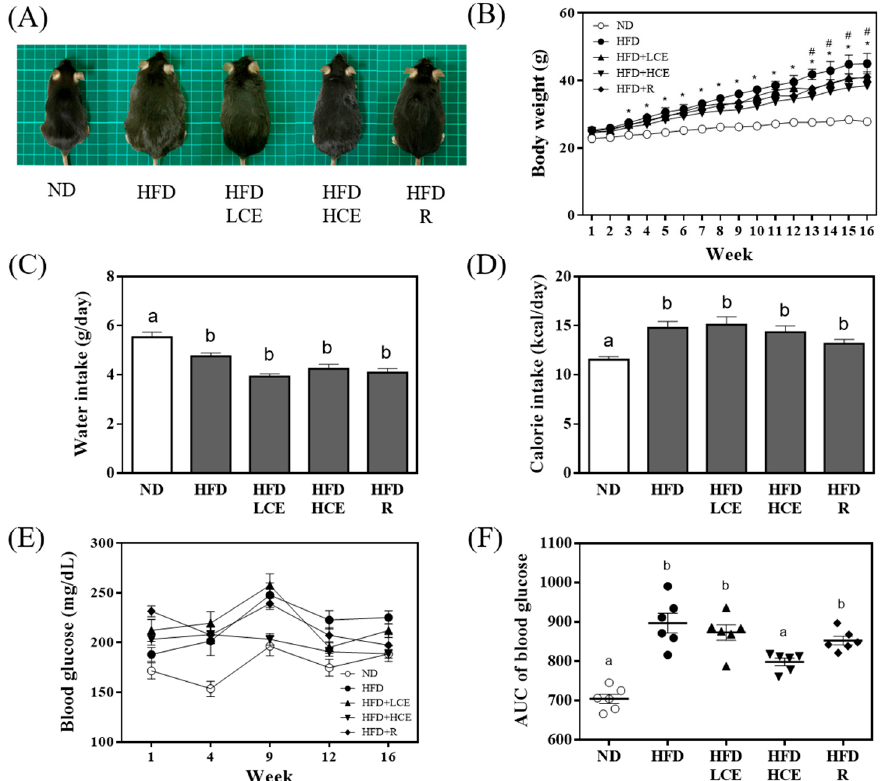
Figure 2. Effect of djulis hull crude extract and rutin on morphology, body weight, water intake, calorie intake, and random blood glucose in high fat diet-induced hyperglycaemia. ( A ) Representative pictures of mice. ( B ) Growth curve of body weight. ( C ) Average water intake. ( D ) Average calorie intake. ( E ) Weekly random blood glucose levels. ( F ) AUC of weekly random blood glucose. ND: normal diet; HFD: high-fat diet; LCE: low dosage of crude extract; HCE: high dosage of crude extract; R: rutin; AUC: area under the curve. Values represent the mean ± SEM ( n = 6). The statistical methods used one-way ANOVA, and the values with different letters and symbols are significantly different at p < 0.05. * p < 0.05 ND vs. HFD; # p < 0.05 HFD vs. HFD/HCE.